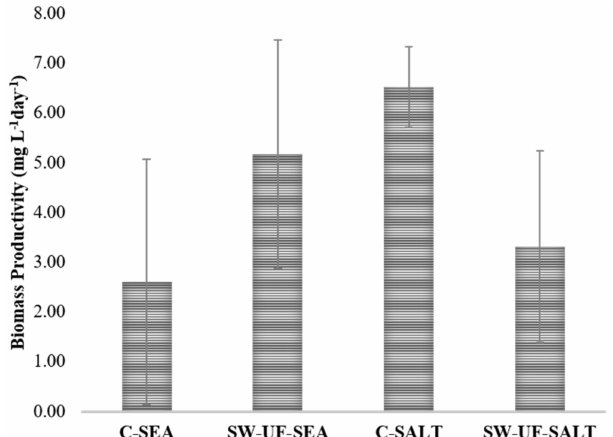
Figure 1. Total biomass productivity of each culture in mgL − 1 day − 1 repeat. C = control media, SW = swine wastewater media, UF = purified by ultrafiltration, RW = raw swine wastewater added after ultrafiltration, SEA = seawater, SALT = saltwater, N =